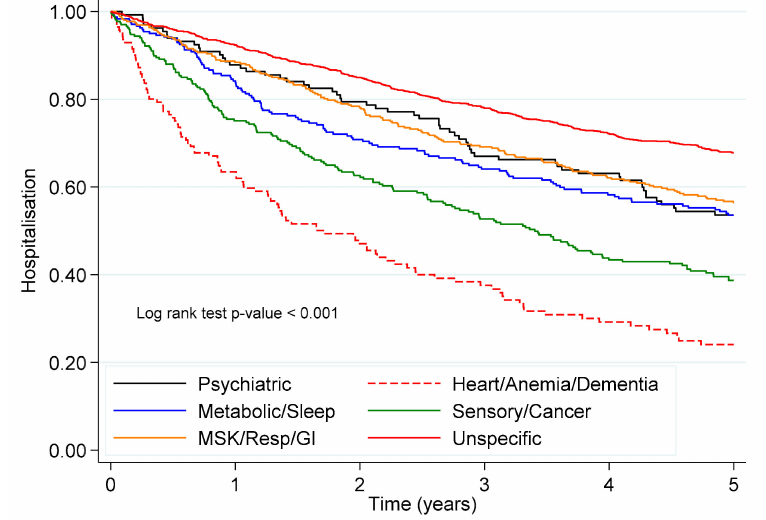
Figure 1. Kaplan–Meier survival estimates for the first unplanned hospitalisation throughout 5 years of follow-up. Abbreviations: GI—gastrointestinal diseases; Resp—respiratory diseases; MSK—musculoskeletal diseases; Cardio—cardiovascular